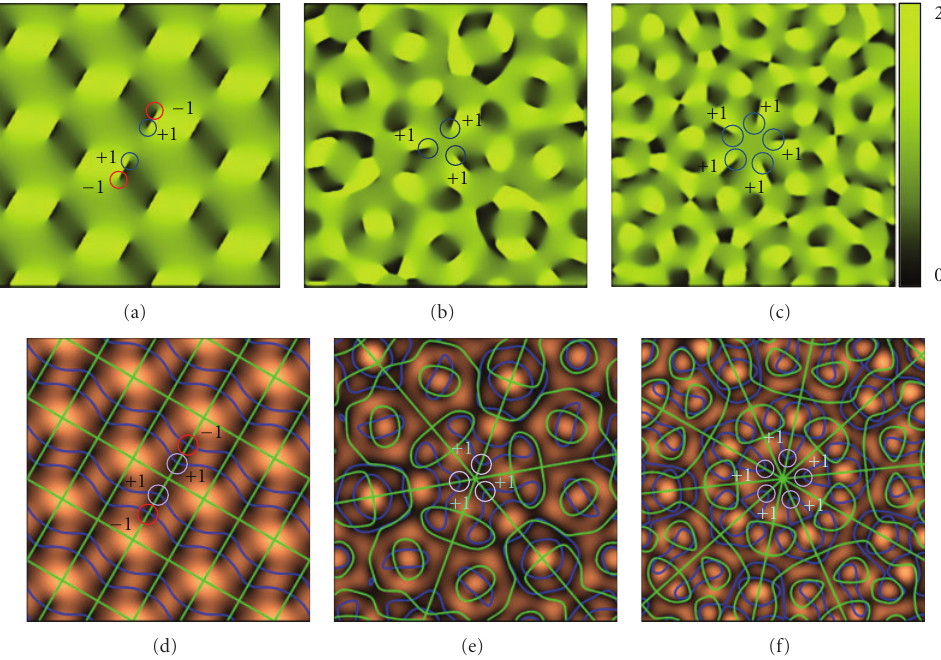
Figure 7: Computational analysis of complex 3D vortex lattices. Taking the multiples of relatively phase-shifted three beams, the numbers of interfering beams involved are, respectively, 6 beams (first column), 9 beams (second column), and 15 beams (third column). (a)–(c) Phase profile. (d)–(f) Zero crossing plot (blue line: zeros of Re E ( r ) and green line: zeros of Im E ( r )). Under perturbation, the unfolding and shifting of the vortices are clearly visible and circled to identify the position.